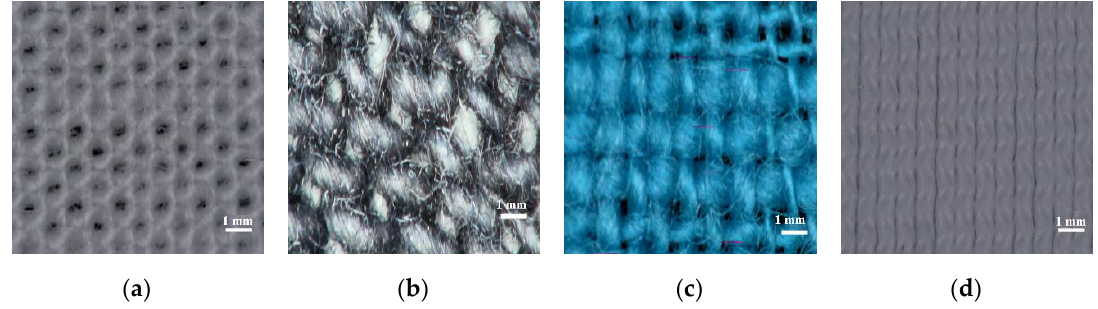
Table 1. Dielectric properties of fabrics.